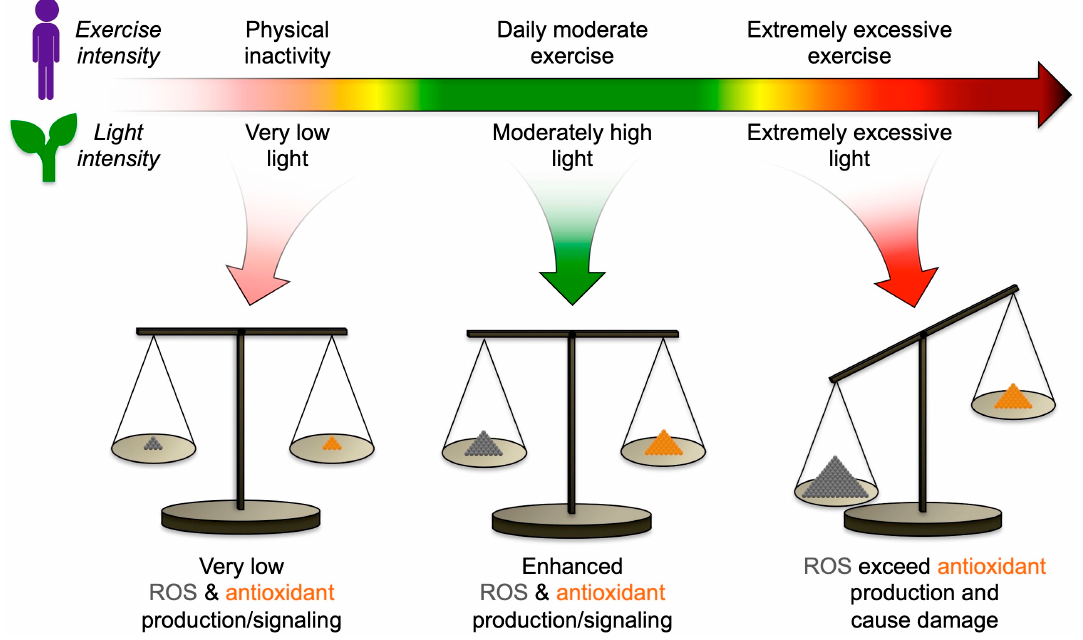
Figure 4. Schematic depiction of the proportion of reactive oxygen (ROS) and antioxidants produced across environmental gradients for the example of exercise intensity in humans and light intensity in plants.